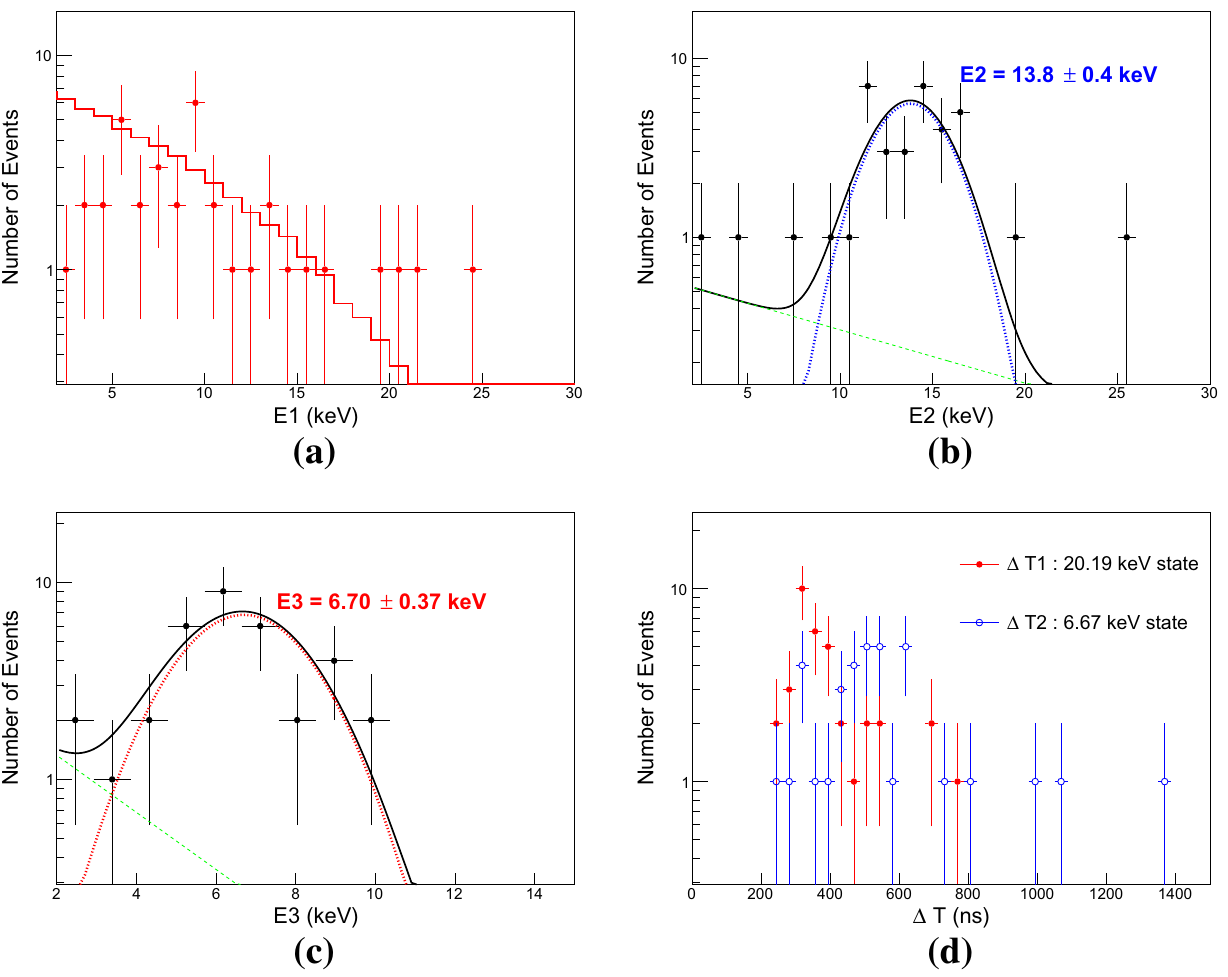
Fig. 7 The energies and (cid:6) T distributions obtained from the three- pulse events are presented. ( a ) The E1 spectrum (points) of three-pulse events is compared with a Geant4-based simulation of β spectra with Q = 25.61keV (solid line). ( b ) The E2 spectrum (points) is modeled with a Gaussian (dotted line) and an exponential background contri-